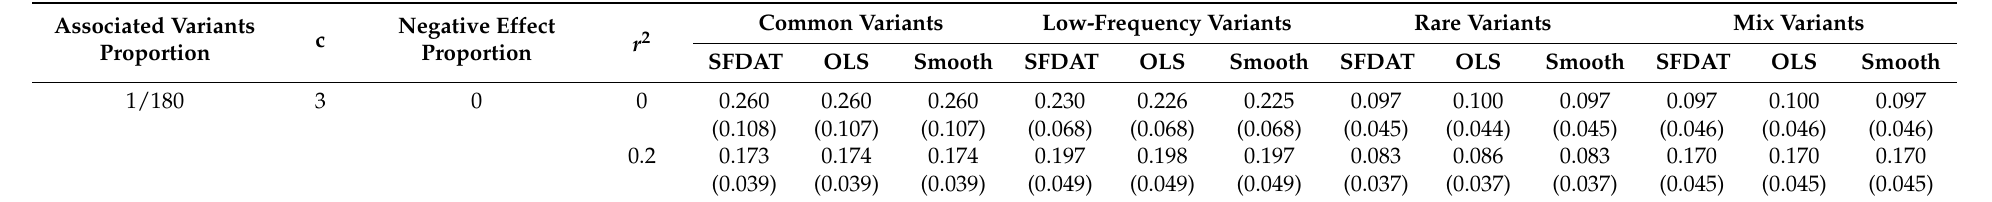
Table 4. The means and standard errors (in the parenthesis) of PMSE for association analysis of simulated quantitative trait based on SFDAT, OLS and Smooth and on linkage equilibrium and linkage